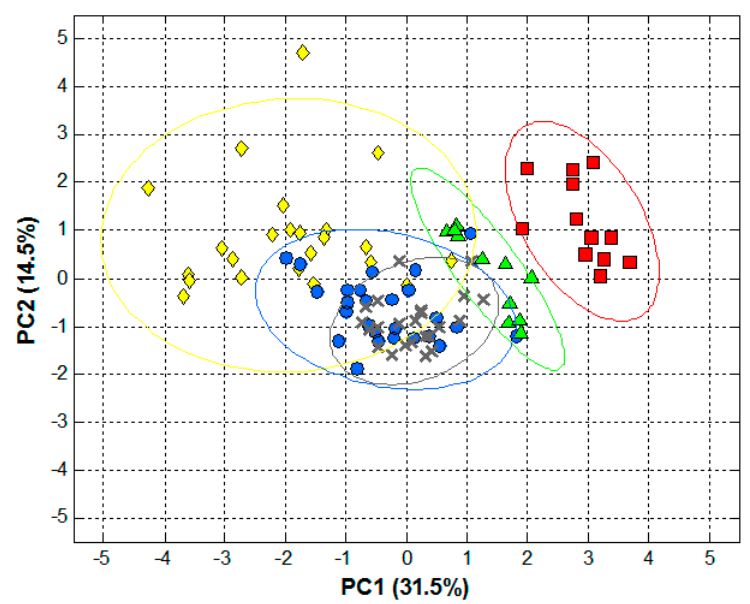
Fig. 3. Score plot obtained after PCA analysis of the paprika samples chromatograms: (green ▲ ) Murcia sweet, (red ■ ) Murcia spicy, (blue ● ) La Vera sweet, (yellow ♦ ) La Vera spicy, and (grey x ) La Vera bittersweet. Ellipses plotted correspond to 95% confidence limits for each of the groups.